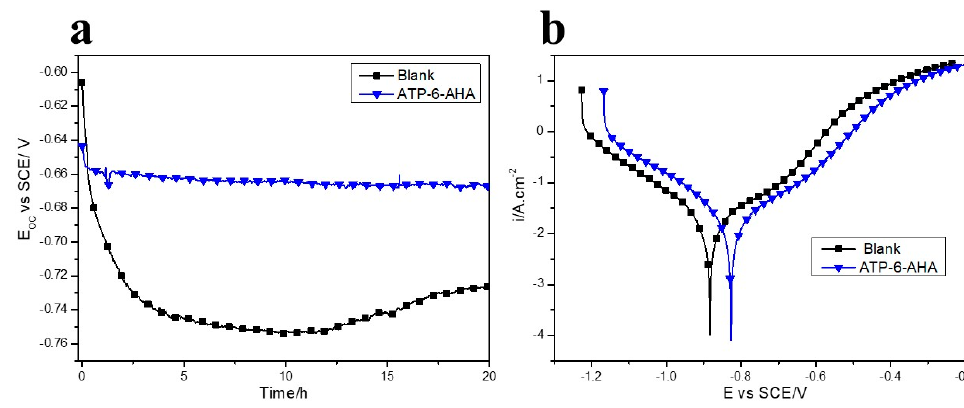
Figure 2. ( a ) Potential and ( b ) polarization curves of S235 low-carbon steel after 20 h of immersion time in 3.5% NaCl with (triangles) and without ATP-6-AHA (squares).